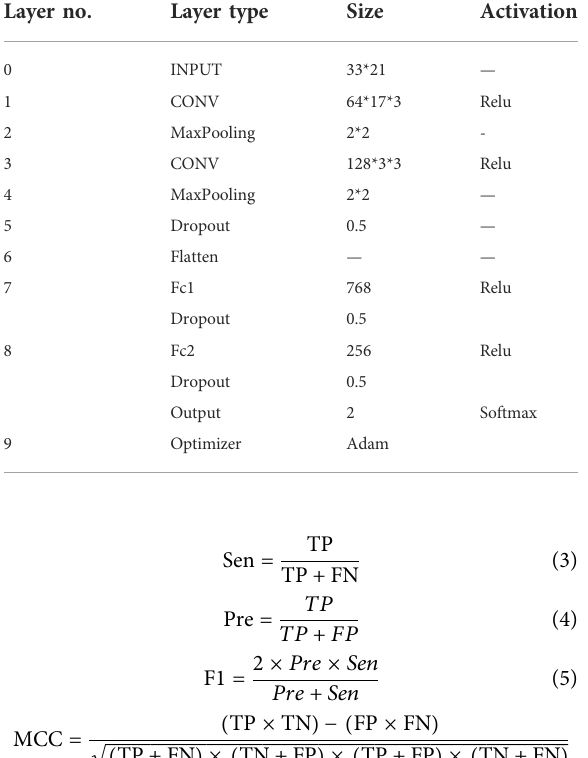
TABLE 2 The hyperparameter settings of each 2D-CNN layer. Layer